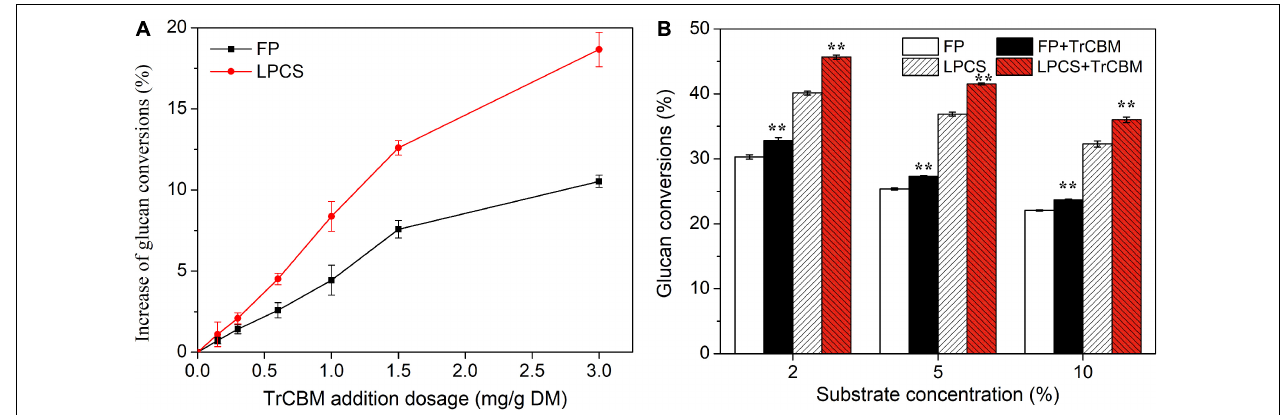
FIGURE 3 | Effect of TrCBM enzyme loading (A) and substrate concentrations (B) on glucan conversions at 72 h in enzymatic hydrolysis of FP and LPCS. **Represents that there was a significant difference ( p < 0.05).